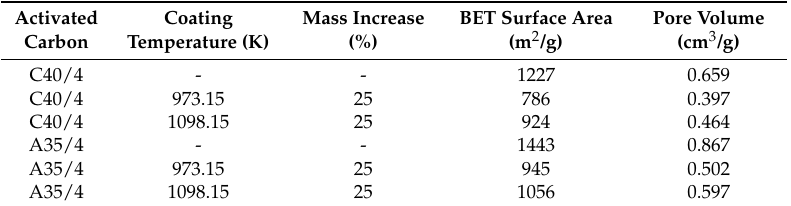
Table 1. Basic properties of materials. Table 1 . Basic properties of materials.